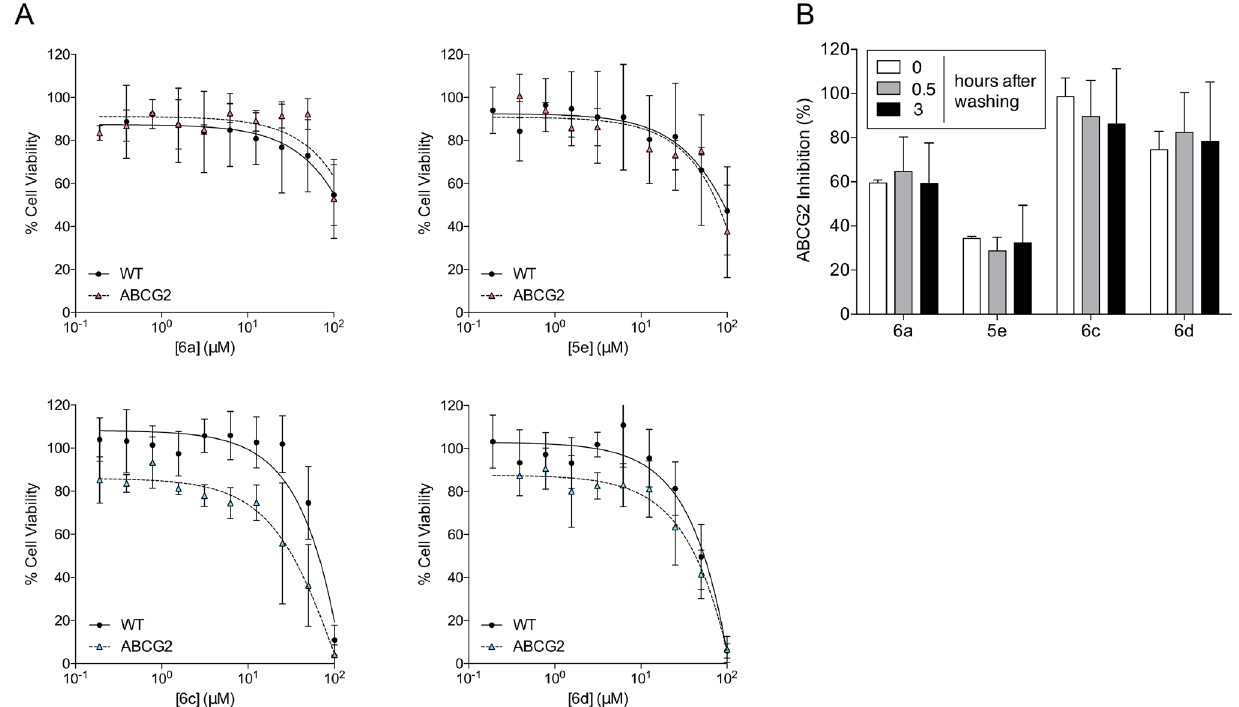
Figure 3. Cytotoxicity of inhibitors and washout assay. Cell viability was determined by MTT assay. ( A ) Cell viability of HEK293- ABCG2 cells and HEK293 (wild-type) control cells upon 72 h treatment with inhibitors at increasing concentrations (0.1–100 µM), as indicated. ( B ) Washout assay performed on HEK293- ABCG2 cells with the compounds at 10 µM. The white bars represent the classical experiment (30 min of concomitant incubation with compounds and mitoxantrone before analysis), grey and black bars represent pre-treatment with compounds for 30 min followed by washing procedure at 0.5 and 3 h, as described in methods. The data are the mean ± SD of three independent experiments performed in